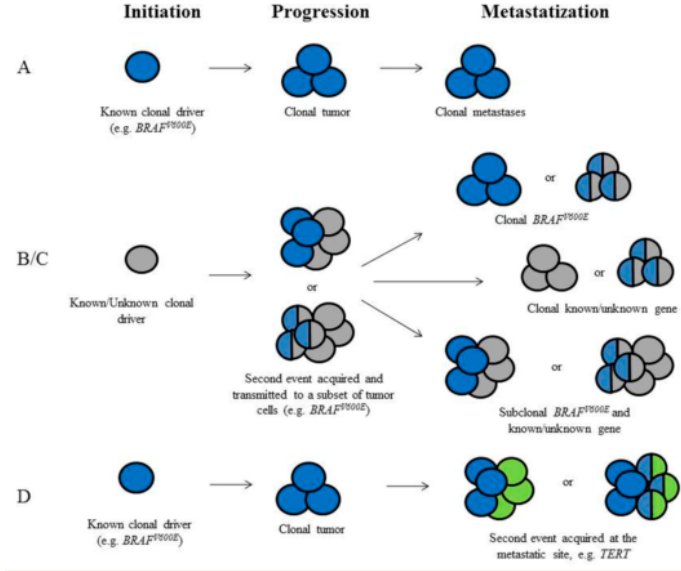
Figure 1. Hypotheses related to papillary thyroid cancer oncogenesis and progression (see text). ( A ) A known mutation occurs in the thyroid follicular cell and leads to the development of the tumor. ( B , C ) The tumor is established by a genetic driver (known or unknown). A second genetic event is acquired either in the same cell ( B ) or in a different cells ( C ) and transmitted with a sub-clonal distribution at the primary site. ( D )A second genetic event is acquired at the metastatic site.